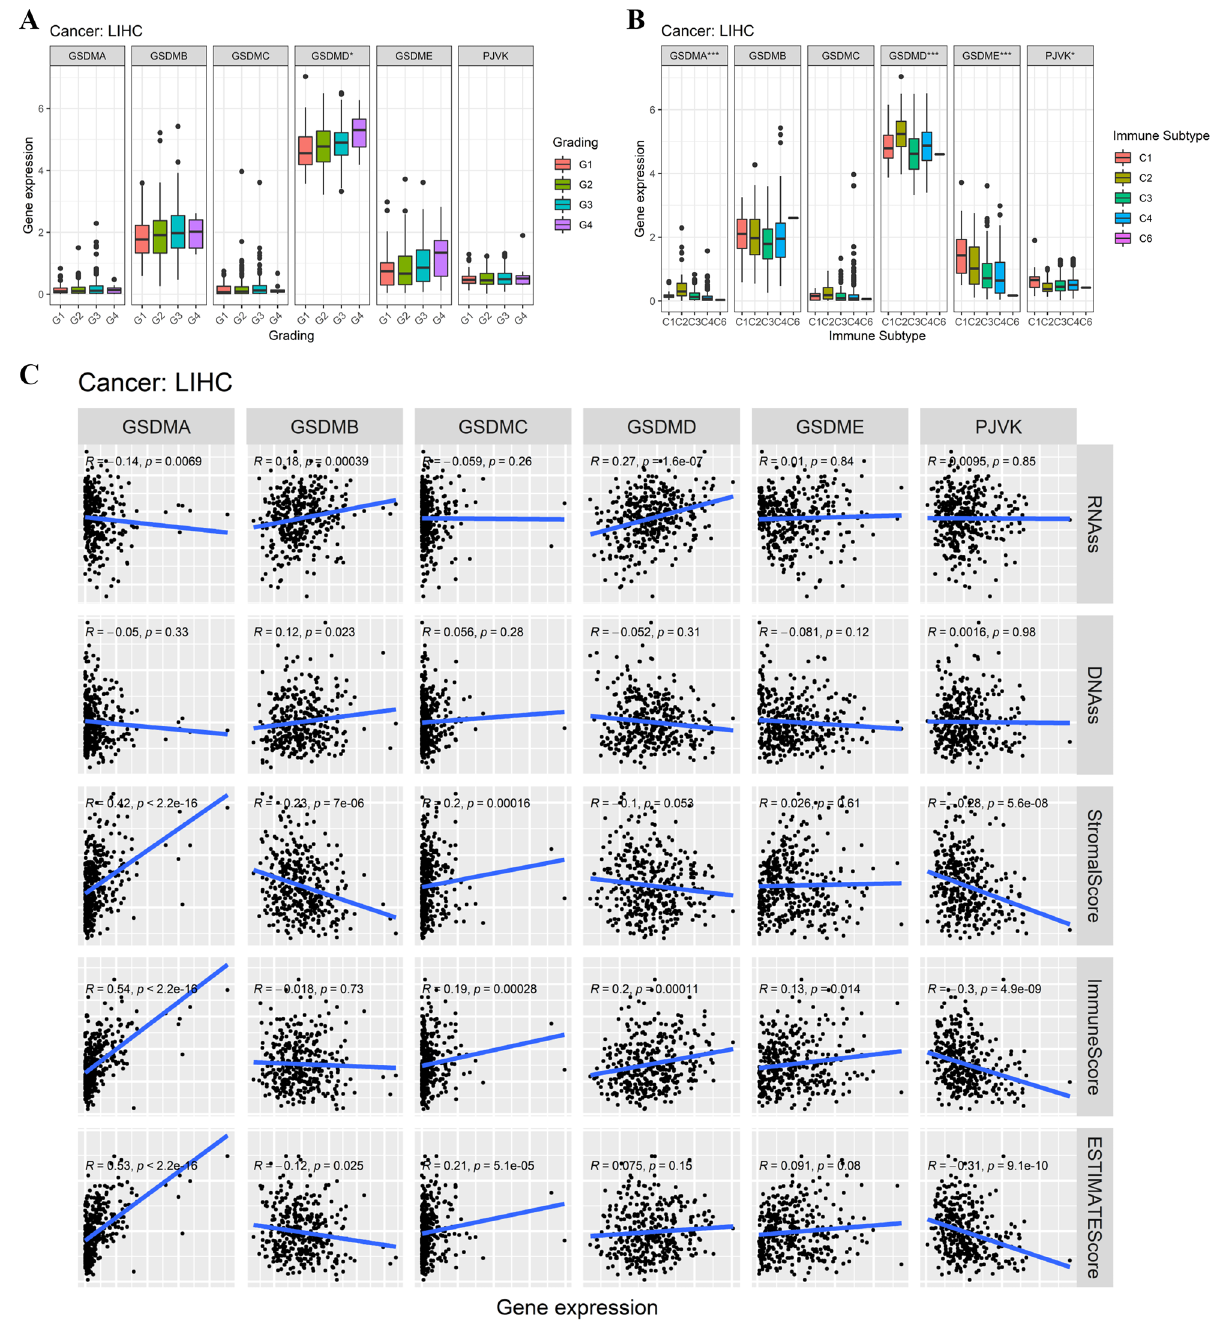
Figure 11. Associations of gasdermin family gene expression with the clinical grade, immune subtype, stemness score, and tumor microenvironment in LIHC. Gasdermin family genes expression levels in various clinical grades ( A ). Associations of gasdermin family gene expression with distinct immune infiltrate subtypes ( B ). Linear regression analysis showing the correlations of gasdermin family gene expression with stemness score and the tumor microenvironment ( C ). P < 0.050, P < 0.010, and P < 0.001were denoted by “*”, “**”, and “***”,